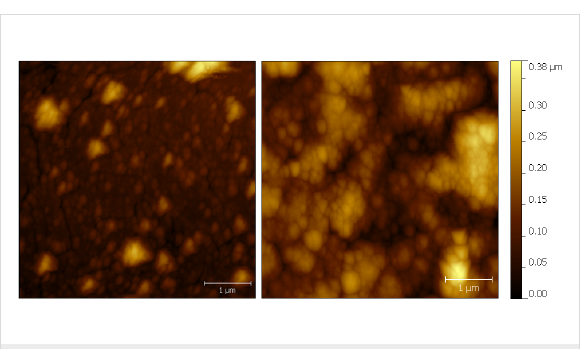
Figure 1: AFM topography images of Prussian blue layer (left) and Ni-HCF layer (right) deposited on top (contact mode images were recorded in air with 0.3 lines/s at a resolution of 512 × 512 lines/